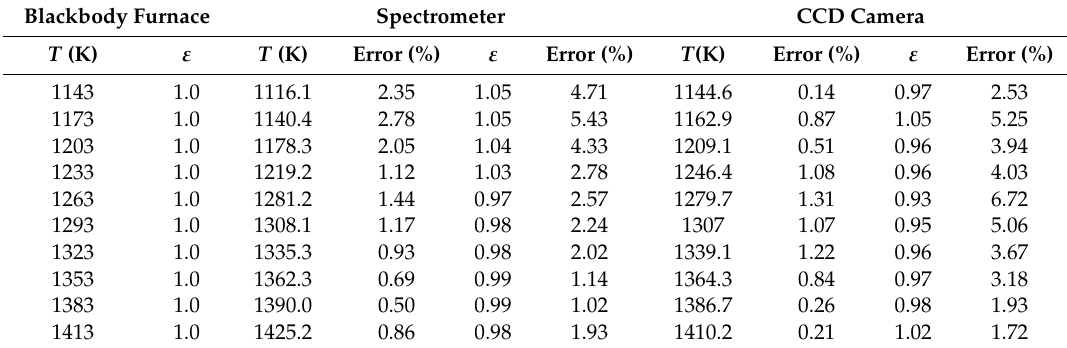
Table 1. Calibration errors of spectrometer and CCD camera.